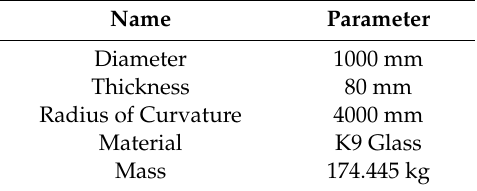
Table 1. The key components of the standard mirror.